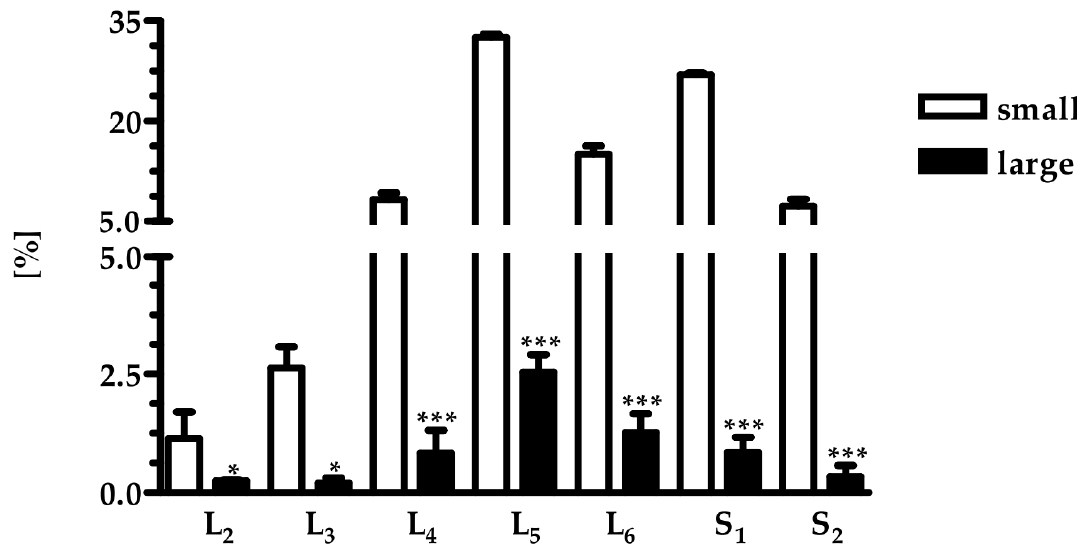
Figure 1. Bar diagram showing the segmental distribution of the skin-projecting neurons in porcine sympathetic chain ganglia following injection of Fast Blue in to the skin. Distribution of the skin-projecting neurons ( n = 4). Bars represent mean number of small—(hollow bars) and large-sized (filled bars) neurons ± SEM located in left ganglia. Asterisks mark statistically significant differences: * p < 0.05; *** p <